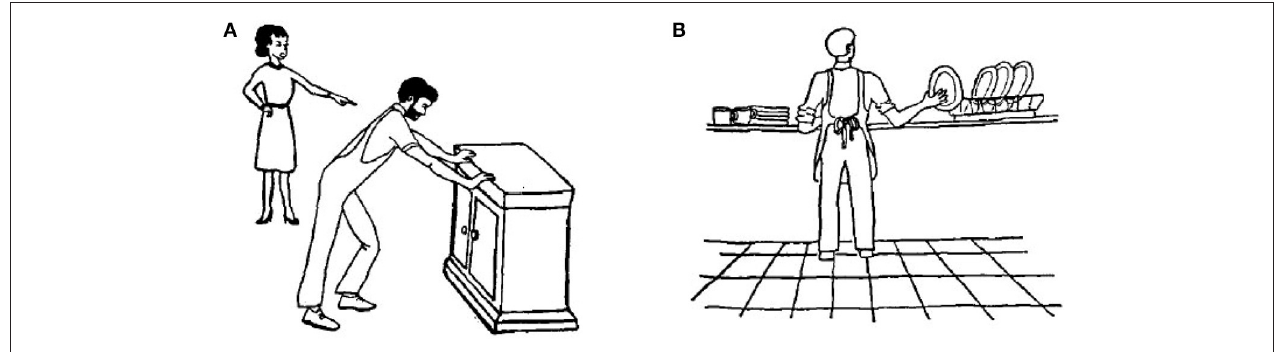
FIGURE 11 | Picture from Experiment 2 by Langford and Holmes